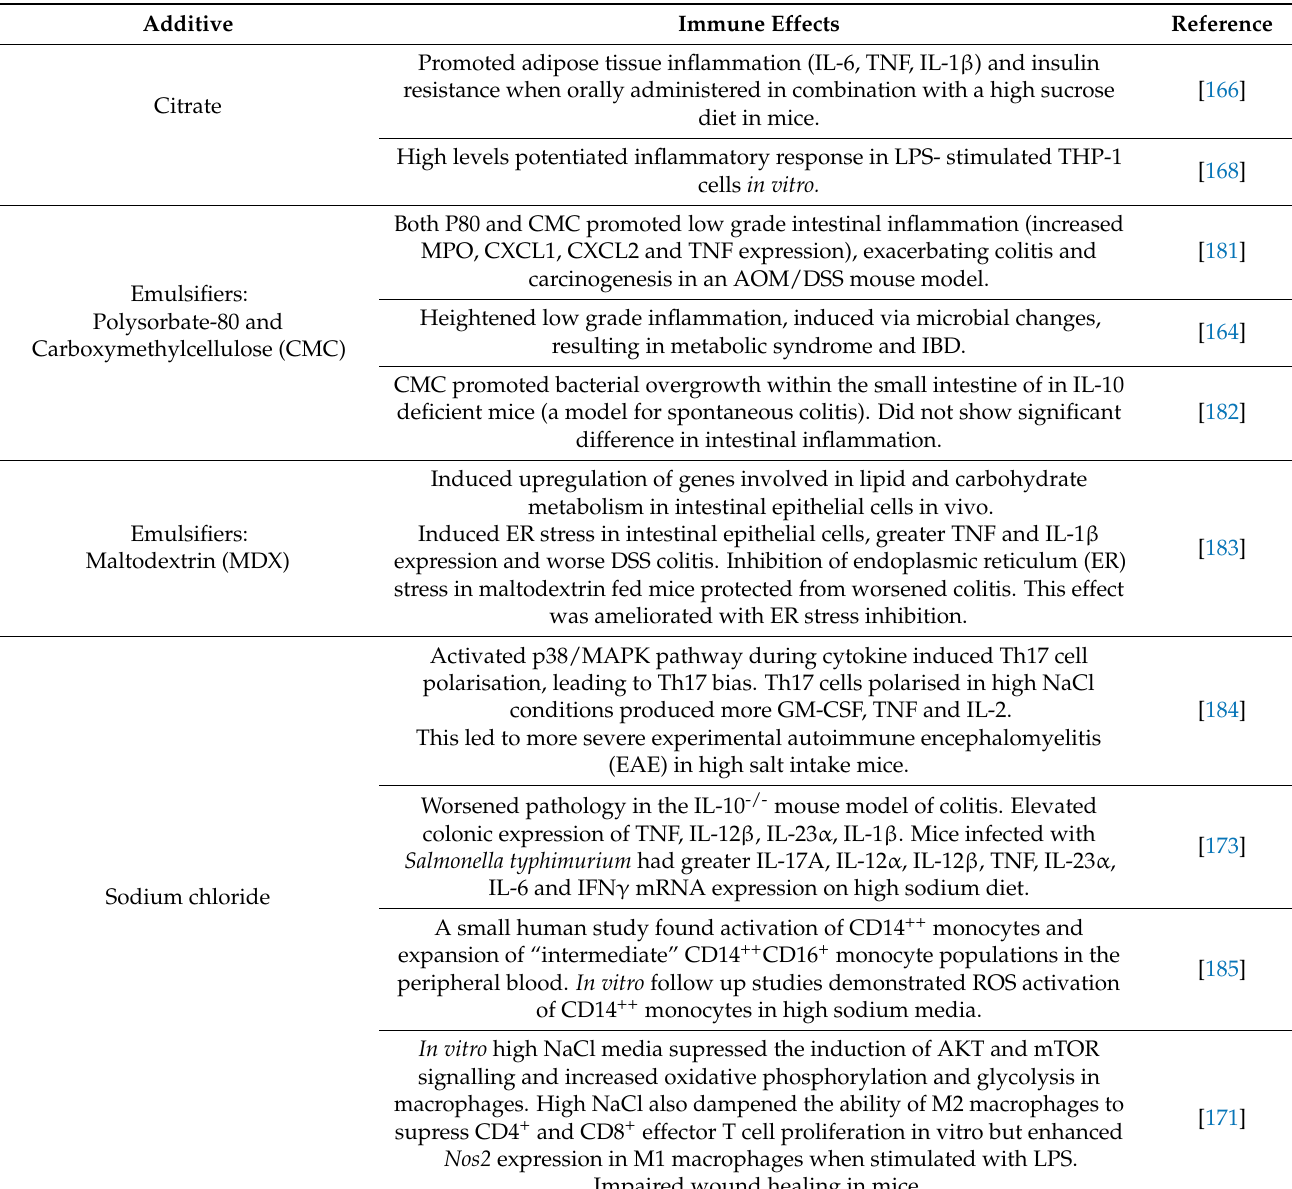
Table 2. Summary of common food additives and immune